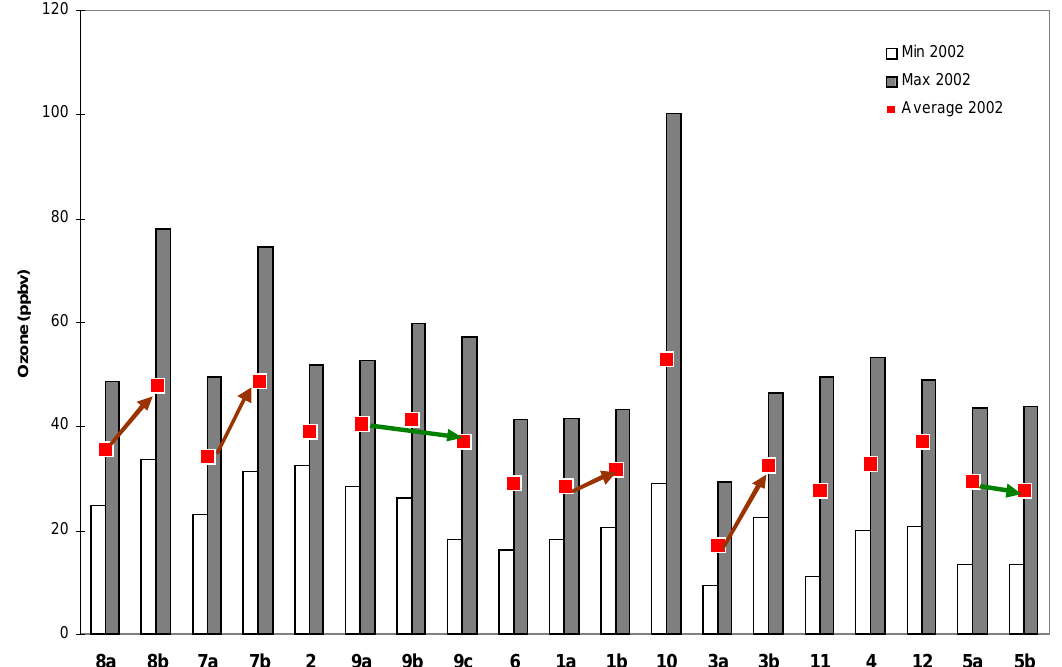
FIGURE 5 . Average, maximum and minimum ozone concentration (biweekly periods) for 2002, the year with highest ozone among the ones included in the paper. Parks ordered by maximum altitude and sampling locations ordered by altitude (m) with in the park.